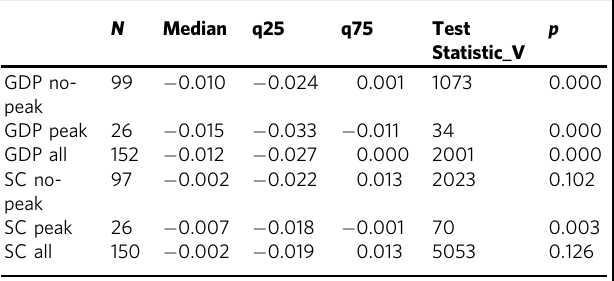
Table 1 Change of GDP effect and structural change (SC) effect before and after